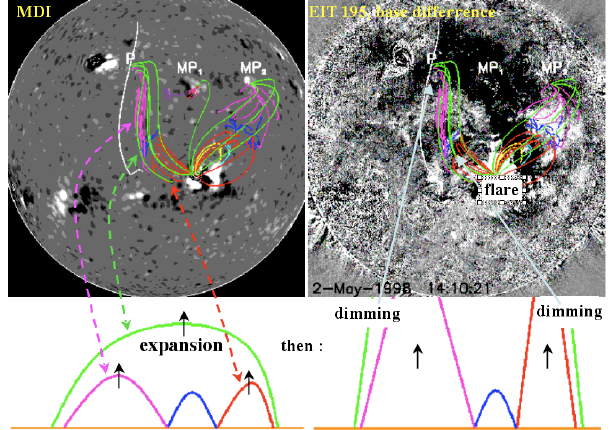
Fig. 14. Formation of large-scale dimmings by the destabilization of trans-equatorial loops. The top panels show a set of computed field lines (with a full Sun potential field extrapolation) on top of the MDI magnetogram (left panel) and a de-rotated base difference image of EIT 195 ˚A (right panel). The magnetic configuration involved in the eruption is quadrupolar (green, pink, blue, and red field lines). The bottom panels show a sketch for the evolution of representa- tive field lines. Reconnection in the quadrupolar configuration pro- vides plasma heating seen as brightenings (located near the blue field lines). The destabilization of the large field lines (green), as well as the lateral ones (pink and red), leads to the formation of large-scale dimmings (Delann´ee et al., 2007).